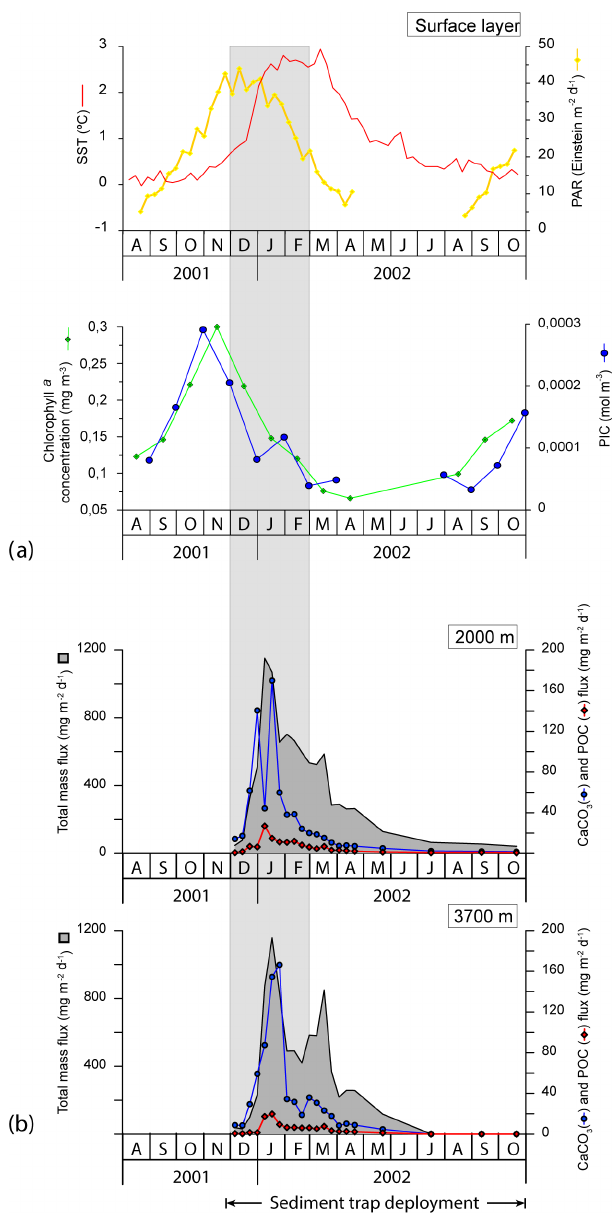
Figure 4. (a) Satellite-derived SST ( ◦ C), PAR (Einstein m − 2 d − 1 ), chlorophyll a concentration (mgm − 3 ) and PIC concentration (molm − 3 ) for the period November 2001 to September 2002. It is important to note that satellite PIC concentration estimates have been reported to be biased for high-latitude systems of the Southern Ocean where the satellite algorithm is thought to produce overesti- mates (Balch et al., 2016; Trull et al., 2018). Therefore, the PIC data presented here should be viewed with caution. (b) Temporal vari- ability of the total mass, CaCO 3 and POC in the < 1mm fraction at 2000 and 3700m of water depth from November 2001 through November 2002 at the 61 ◦ S site (Rigual-Hernández et al., 2015a). Grey strips represent summer.